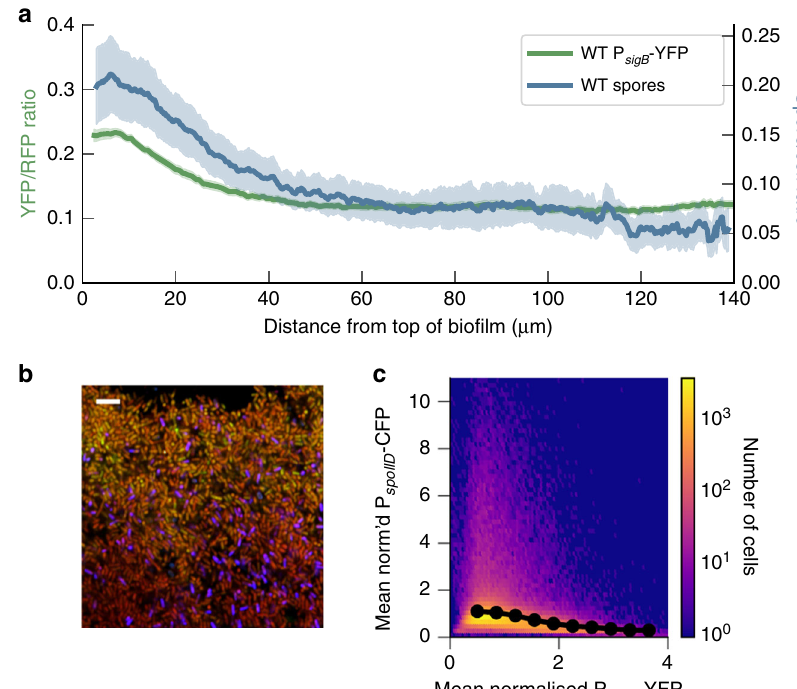
Fig. 5 B. subtilis bio fi lms exhibit co-located spore and σ B gradients, even though σ B represses sporulation in single cells. a The wild type gradients of σ B (the ratio of P sigB -YFP to P sigA -RFP, n = 24 from fi ve experiments) and spore density (calculated from cells expressing late stage sporulation marker, P sspB - YFP, n = 11 from four experiments). Error bars indicate the SEM. b Representative image showing coexistence of sporulating cells and σ B expressing cells at the top of the bio fi lm. Green channel is P sigB -YFP, blue channel is P spoIID -CFP, red channel is P sigA -RFP. The top of the bio fi lm is at the top of the image. Scale bar is 5 μ m. c Bivariate histogram showing the frequency of cells co-expressing P sigB -YFP and P spoIID -CFP. The fl uorescent values are mean normalised for each image. The data represent two tilescan images, each covering ~3 mm of bio fi lm, from two different experiments and 372,689 cells. Source data are provided as a Source Data fi